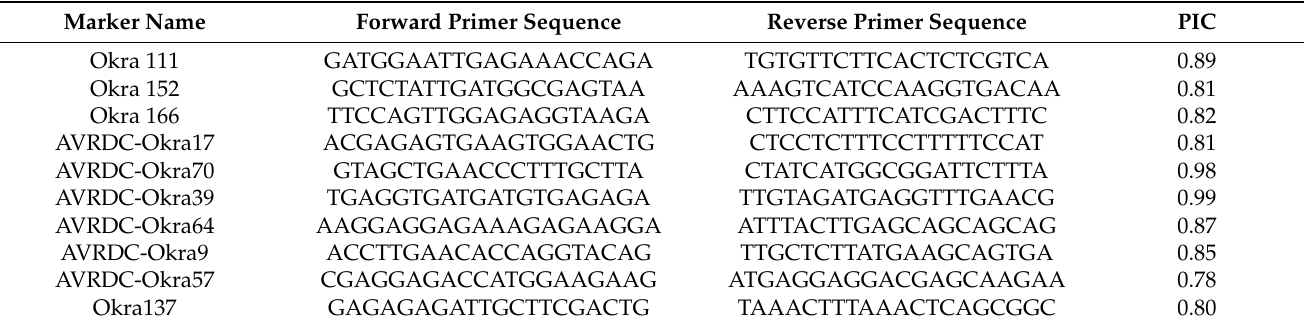
Table 2. Description of the SSR primers used for genotyping of 26 okra landrace